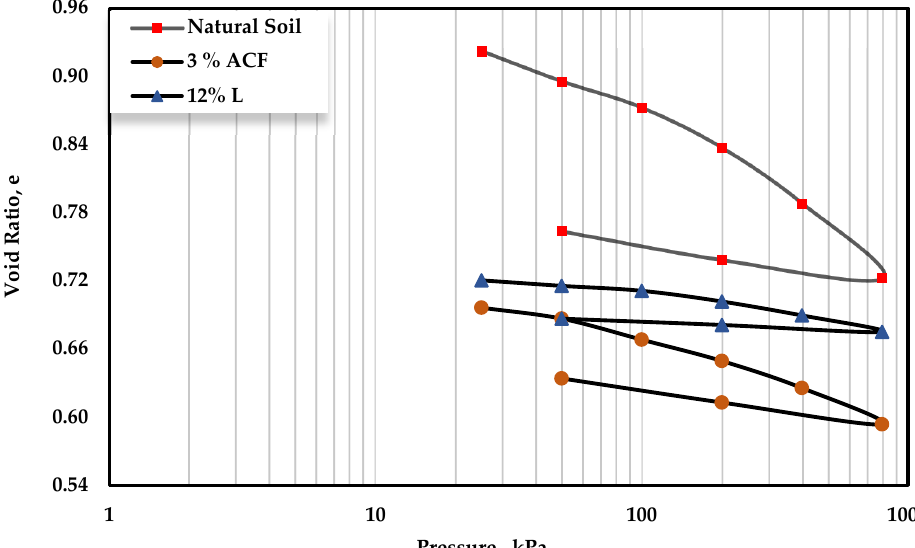
Figure 9. Compressibility curves (e–log P